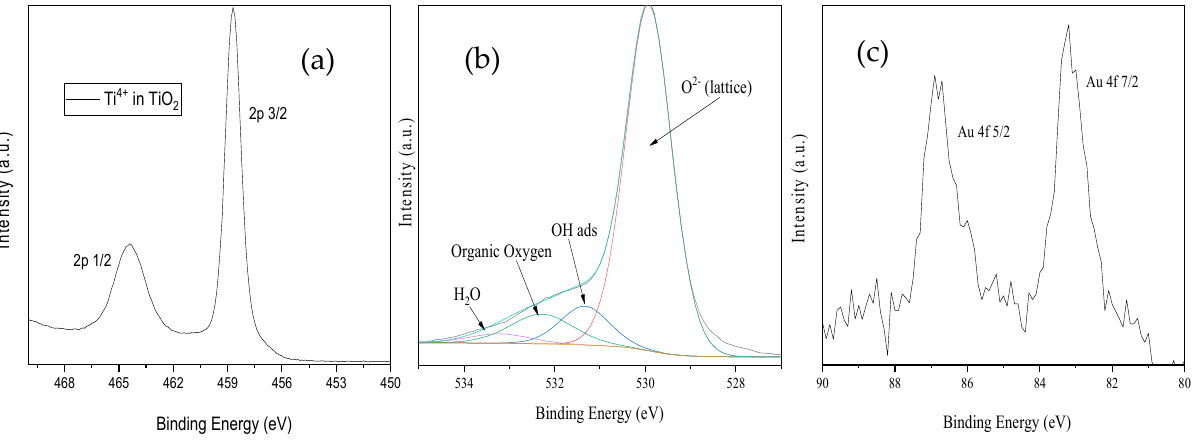
Figure 7. High-resolution XPS spectra: Ti 2p ( a ); the deconvoluted O 1s singlet ( b ); Au 4f ( c ). The titanium 2p high-resolution spectrum (Figure 7a) revealed the presence of the Ti 4+ oxidation state typical for TiO 2 at binding energies (BEs) of Ti 2p 3/2 = 458.8 eV and 464.3 eV for Ti2p 1 [33]. Additionally, the deconvolution revealed the presence of the Ti 3+ 2 oxidation state, due to the presence of a reductant medium at Ti 2p 3/2 = 457.1 eV and Ti 2p 1/2 462.9 eV. The deconvoluted high-resolution spectrum of the O1s singlet (Figure 7c) revealed four oxygen chemical species in the BEs region of 535–528 eV; thus, O 2 − bonded in the TiO 2 lattice was assigned to O1s at 529.9 eV, while the OH groups and water molecules adsorbed on the surface were detected at 531.5 eV and 533.2 eV, respectively. A small fraction of organic oxygen, originating from the carbon tape, was attributed to O1s located at 532.2 eV. The Au 4f high-resolution spectrum (Figure 7b) with Au 4f7/2 at 83.2 eV and Au 4f 5/2 at 86.78 eV highlighted the presence of the gold metallic nanoparticles (10 nm). It is worth mentioning that the formation of gold metallic NPs is characteristic for binding energies (BEs) shifted towards lower values as compared with Au metallic nanoparticles, which is attributed to the Au 4f7/2 transition around 84 eV [34]. A typical diffractogram pattern for the TiO 2 –Au powder is given in Figure 6 (right). The atanase and rutile phases of TiO 2 and Au were identified from the experimental XRD pattern using the powder diffraction files 00-064-0863, 00-021-1276, and 03-065- 2870,